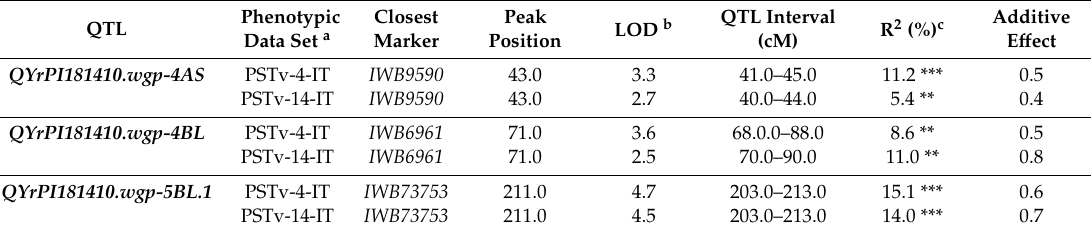
Table 4. Quantitative trait loci (QTL) associated with stripe rust all-stage resistance detected in wheat genotype PI 181410 using the recombinant inbred line population derived from AvS × PI 181410.